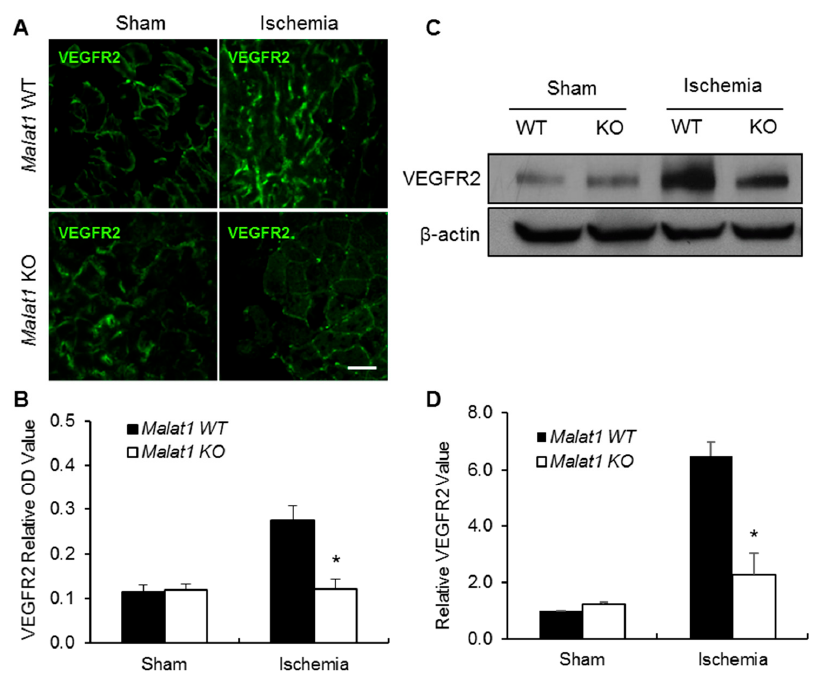
Figure 2. Genetic deletion of Malat1 gene attenuates VEGFR2 expression in ischemic hindlimb gastrocnemius muscles. ( A ) Representative immunofluorescent images showing VEGFR2-positive vessel-like structures in transverse sections of sham and ischemic hindlimb gastrocnemius muscles from Malat1 WT and Malat1 KO mice ( n = 5); ( B ) Quantitative analysis of VEGFR2-positive staining in panel ( A ); ( C ) The protein levels of VEGFR2 were determined by Western blotting, with β -actin as the loading control; and ( D ) Quantitative analysis of VEGFR2 expression in sham and ischemic hindlimb gastrocnemius muscles from Malat1 WT and Malat1 KO mice. Experiments were repeated three times and representative blots are displayed. Data are expressed as mean ± SEM. * p < 0.05 vs. Malat1 WT + ischemia group. Scale bar represents 50 µm.